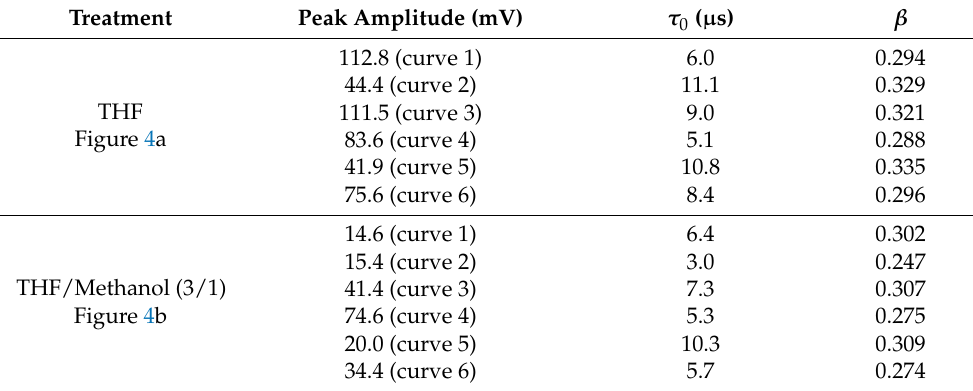
Table 1. The peak amplitudes U 0 of the SPV signals and fitting parameters τ 0 and b for the decays shown in Figure